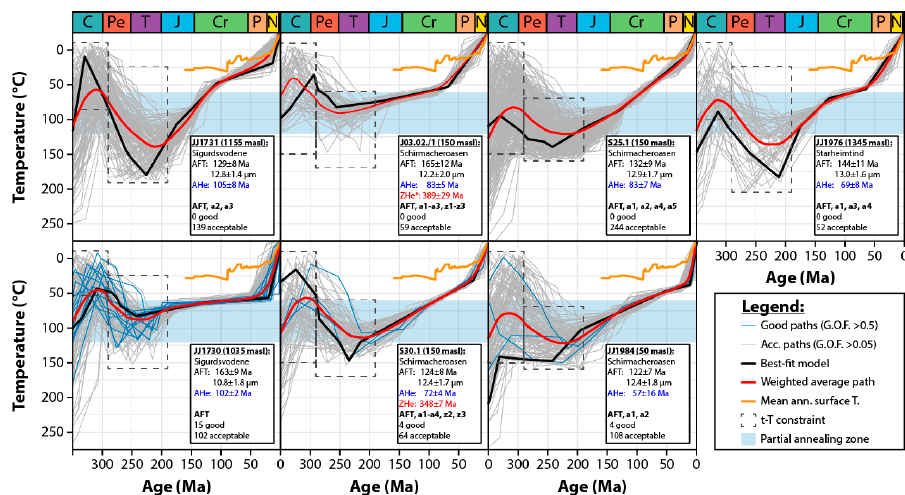
Figure 8. Modelled thermal histories from the continental wedge samples. ZHe age (red) is given as unweighted mean age and 1 σ error. * ZHe data included for modelling of sample J03.02./1 are from sample J02.02./2 at the same locality. For further explanations, see Figure 6.